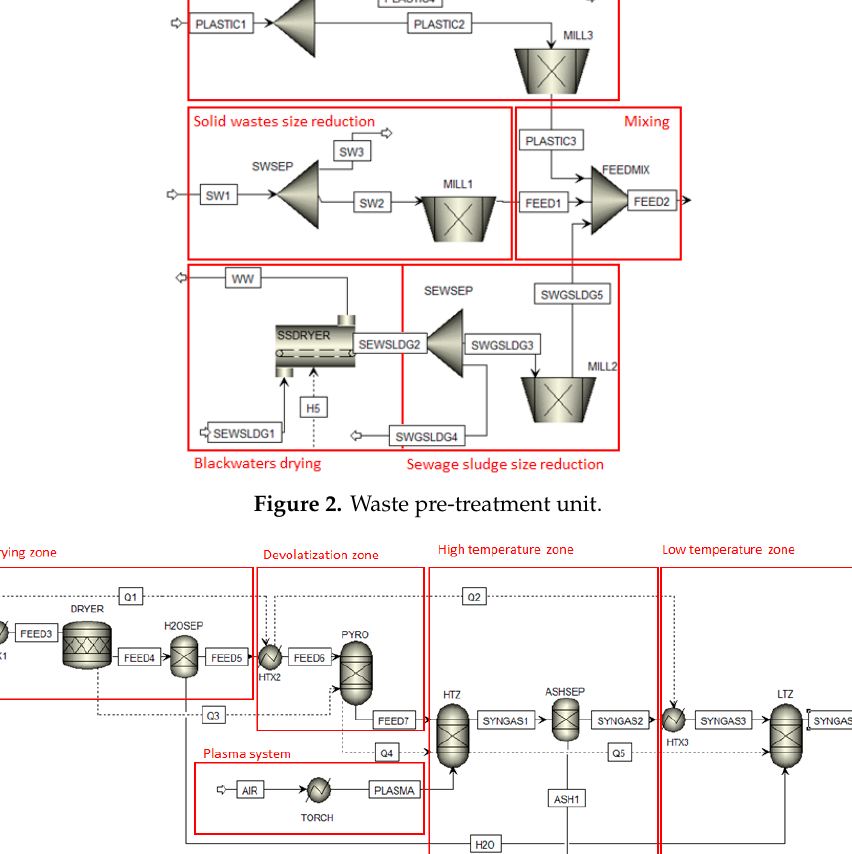
Figure 3. Gasification unit.